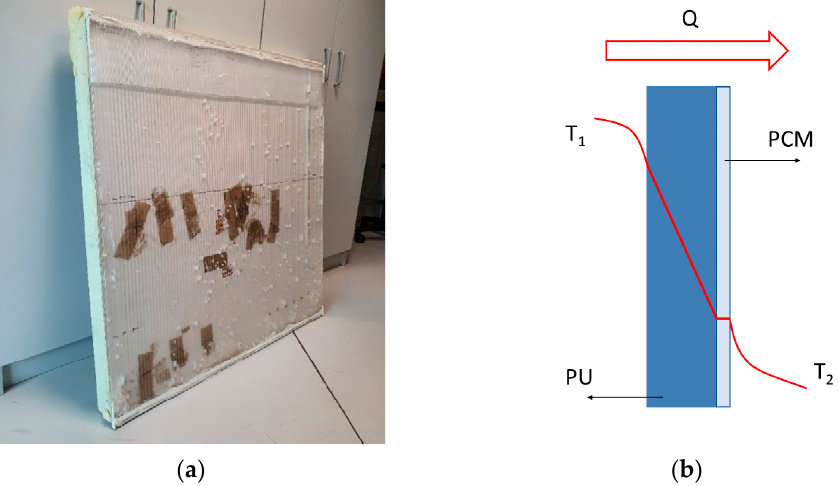
Figure 1. ( a ) The tested wall with a layer of phase change material; ( b ) Heat flow through the proposed wall structure.